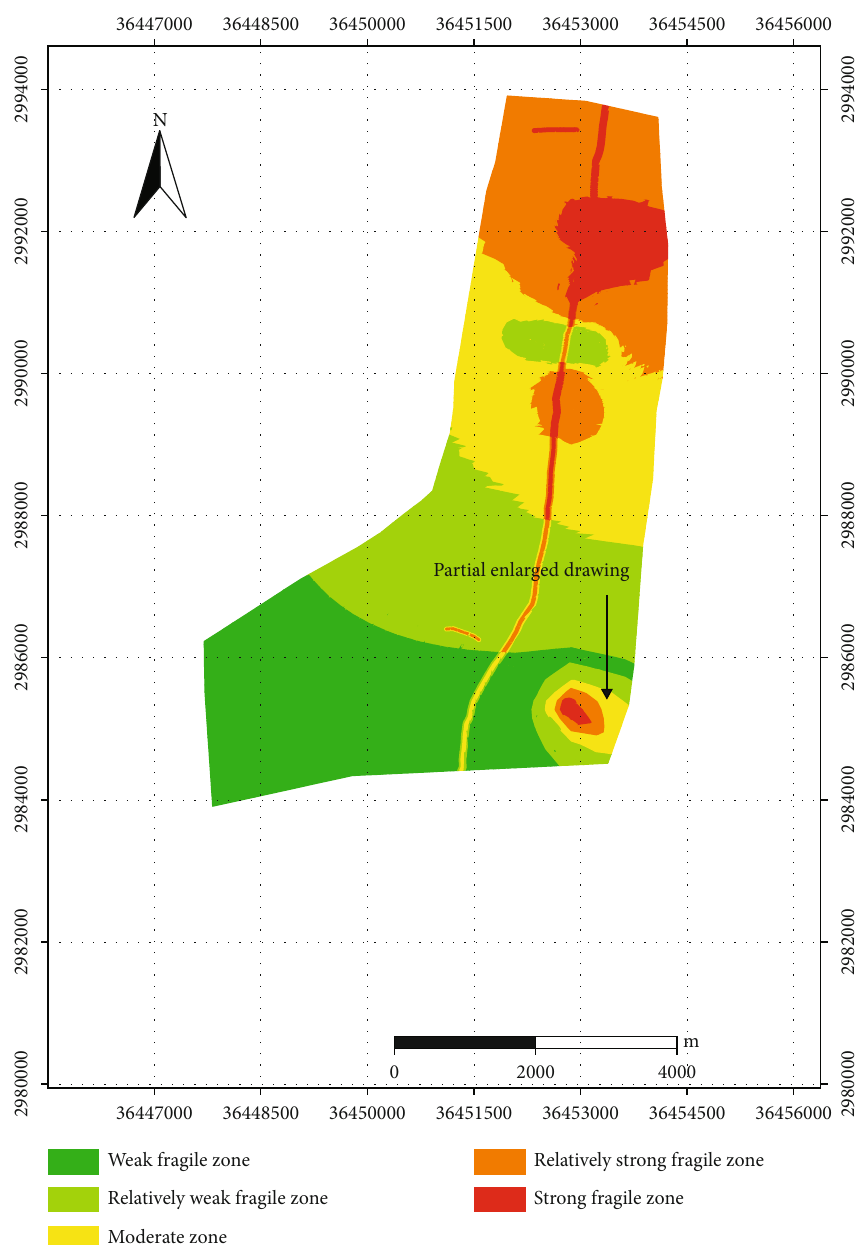
Figure 4: Risk partition map based on